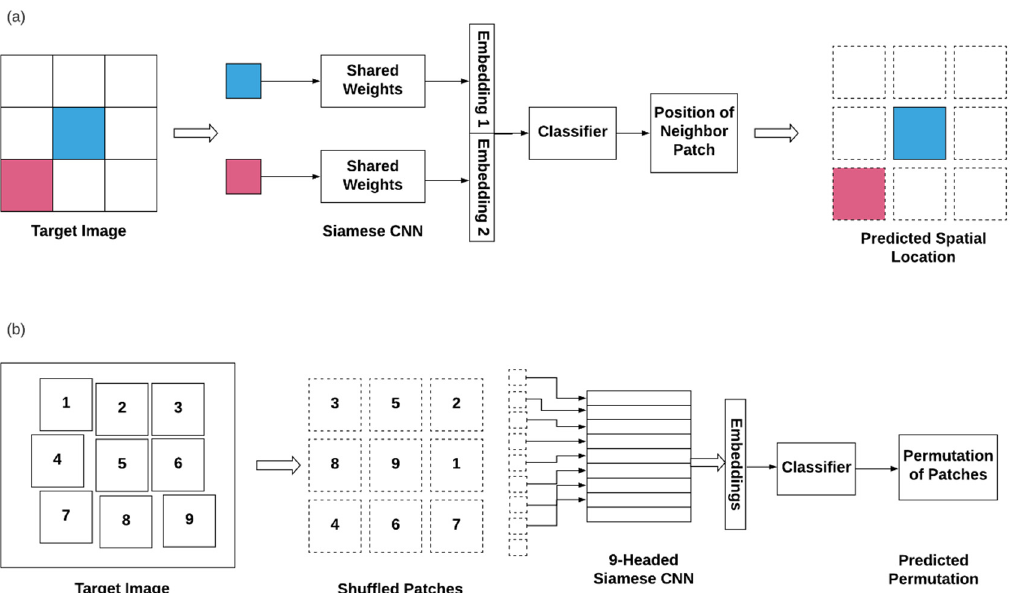
Figure 6. ( a ) An illustration of the algorithm used by Doersch et al. [33]. A central patch and a surrounding patch are extracted from an image and encoded by a CNN, which then predicts the relative location of the neighbor patch. ( b ) An illustration of the algorithm used in the Context Free Network [34]. Nine spatially close patches are shuffled and then embedded by a CNN, which predicts the original permutation of the patches.